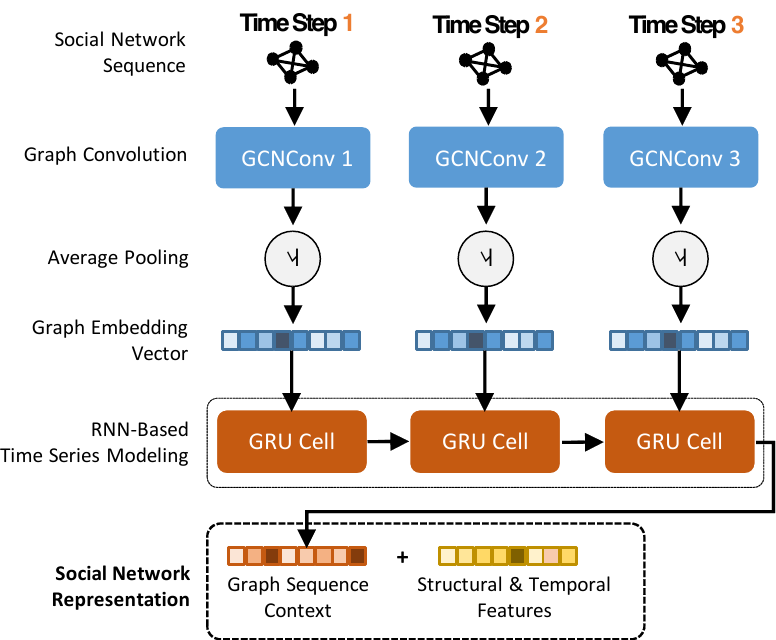
Figure 4. The architecture of social network